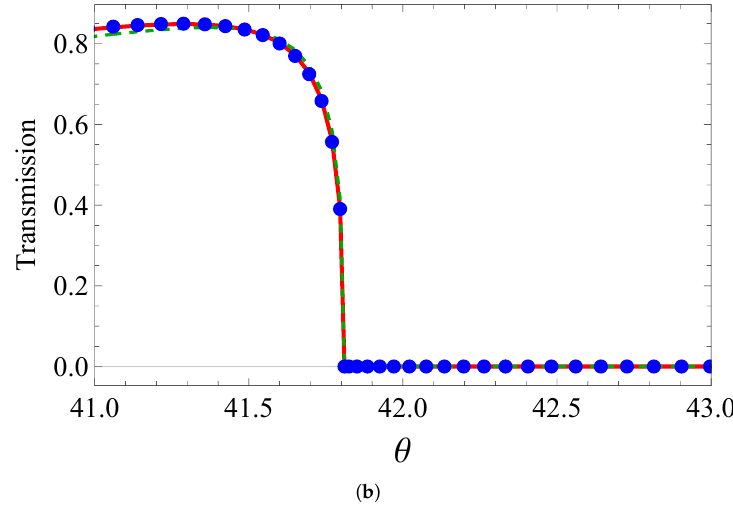
Figure 4. ( a ) Absorption and ( b ) transmission of circular cylinders as a function of the incidence angle θ (degrees): BEM calculation (solid line), isotropic layer (dashes), nonisotropic medium (circles).